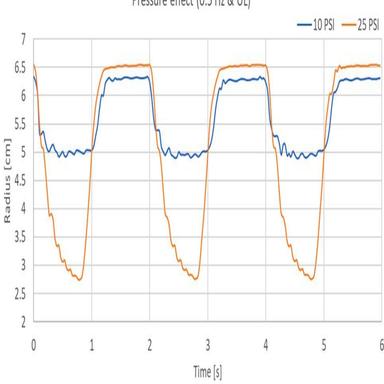
Radius – pressure effect (0.5 Hz & UL).